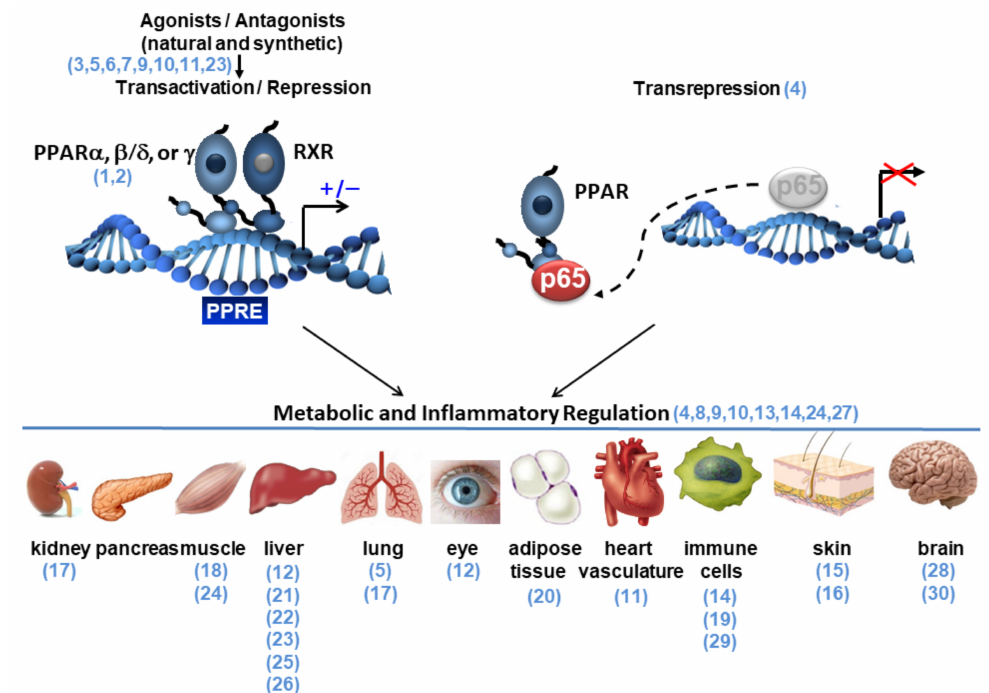
Figure 1. Modes of action of PPARs in transcription transactivation and transrepression (only one of the several mechanisms of transrepression is shown). A non-exhaustive list of the target organs subjected to PPAR-mediated metabolic and inflammatory regulation is shown. The reference numbers (in blue and in parentheses) refer to the articles quoted in this Special Issue (see References); in the figure, they are listed and grouped according to the topic addressed in the corresponding articles. PPRE: peroxisome proliferator hormone response element. p65 subunit of NF- κ B. RXR: retinoid X